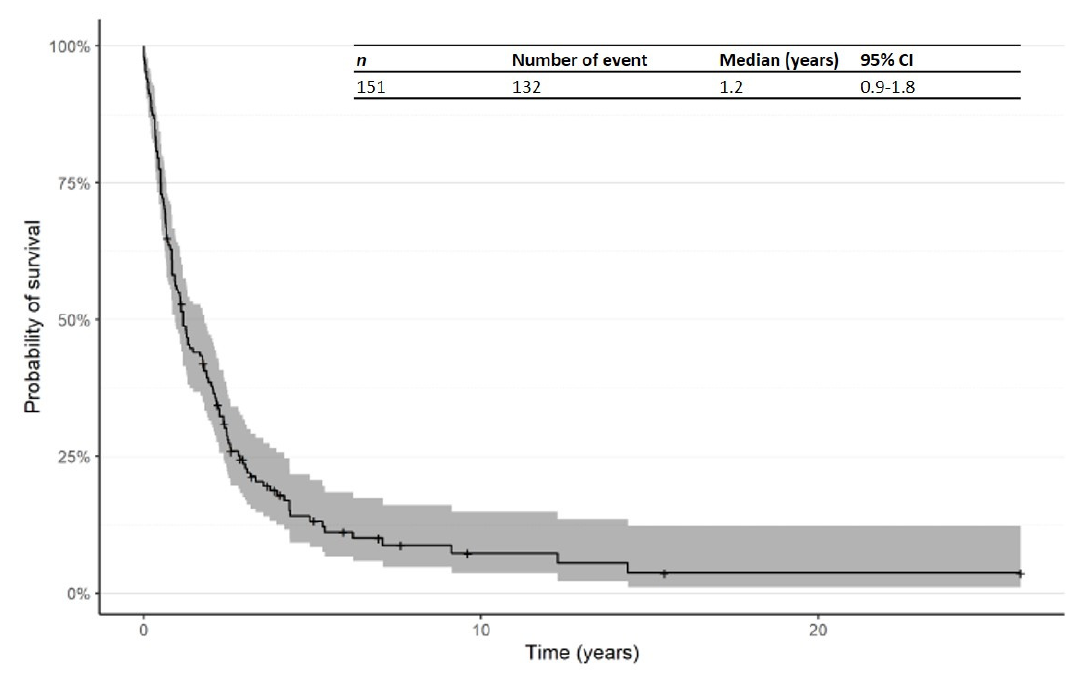
Figure 4. Kaplan–Meier curve for OS from time of R/R1 by primary subtype.